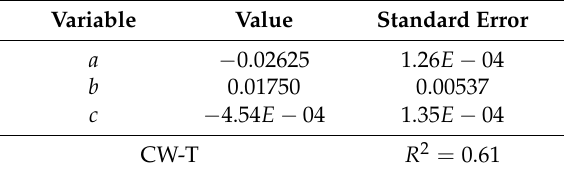
Table 17. Correlation modeling between Relative Humidity and Noise Level at